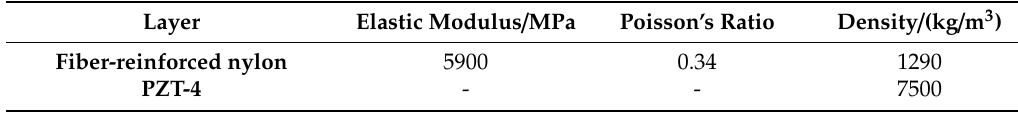
Table 2. Model material parameters.